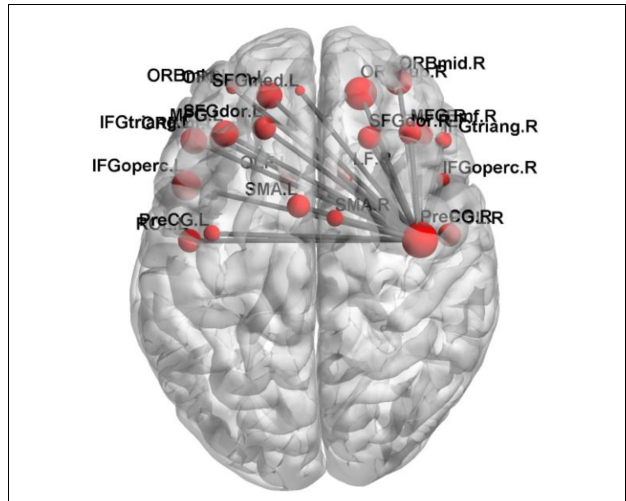
FIGURE 7 | The functional connectivity between PreCG and other brain regions.